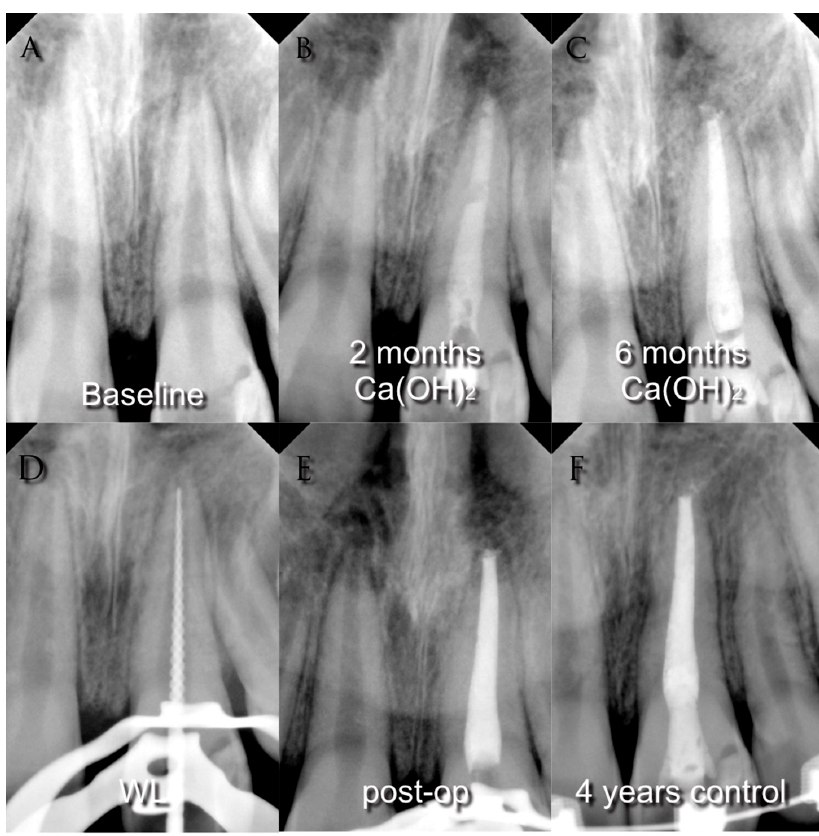
Figure 1. ( A ) Pre-operative radiograph of a young necrotic upper left central incisor with periapical lesion; ( B ) radiograph after two months medication with calcium hydroxide; ( C ) radiograph after six months medication with calcium hydroxide; ( D ) working length determination; ( E ) post-operative radiograph; ( F ) four-years control radiograph.